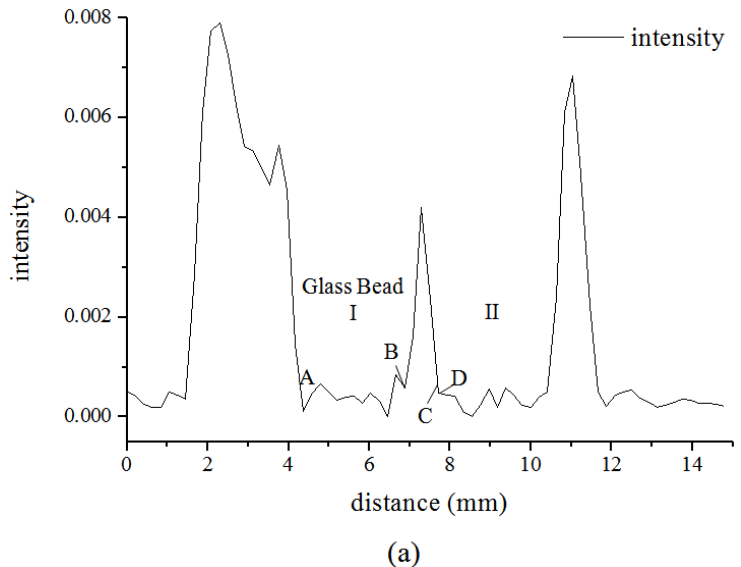
Figure 7. The images of the MRI signal intensity along the line in Figure 5. ( a ) At 10 min; ( b ) At 145